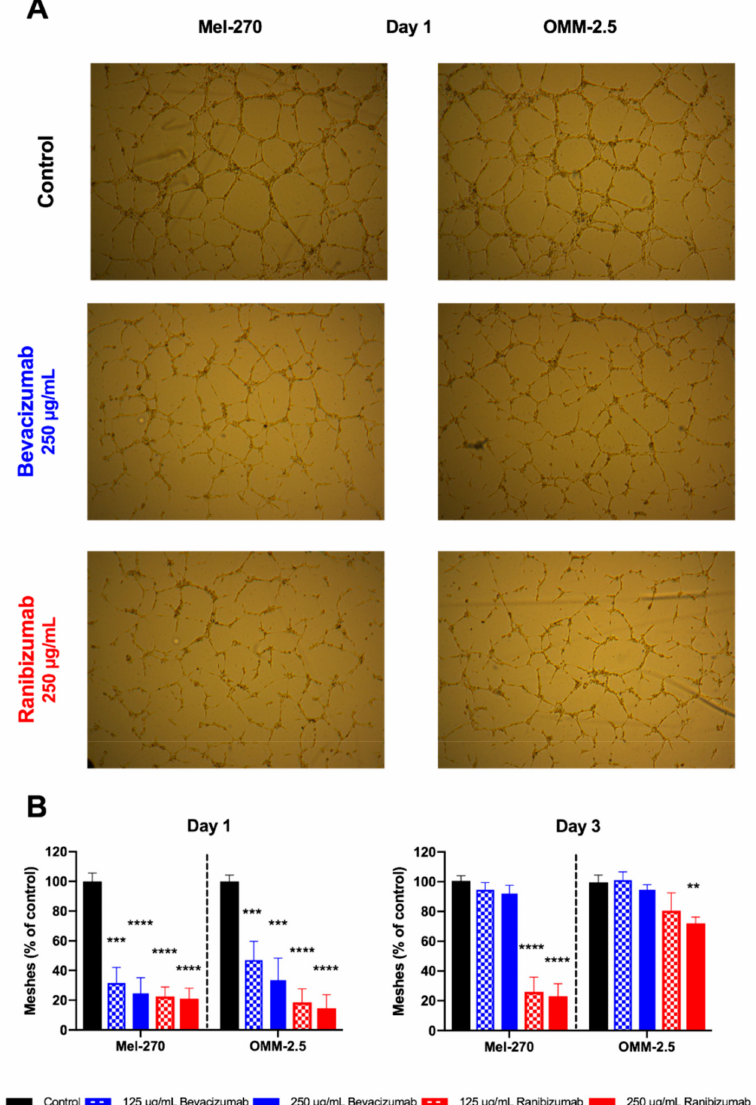
Figure 6. Angiogenic activity of UM cells after a one-day exposure to bevacizumab or ranibizumab. ( A ) Human umbilical vein endothelial cells (HUVECs) were seeded on matrigel and incubated with the conditioned medium of Mel-270 or OMM-2.5 cultures. The number of fully shaped meshes was automatically counted. Images are shown for day one conditioned medium from Mel-270 and OMM-2.5 cells after a one-day incubation with 250 µ g / mL bevacizumab or ranibizumab, compared ( B ) Exposure of the UM cells to bevacizumab for one day significantly suppressed the